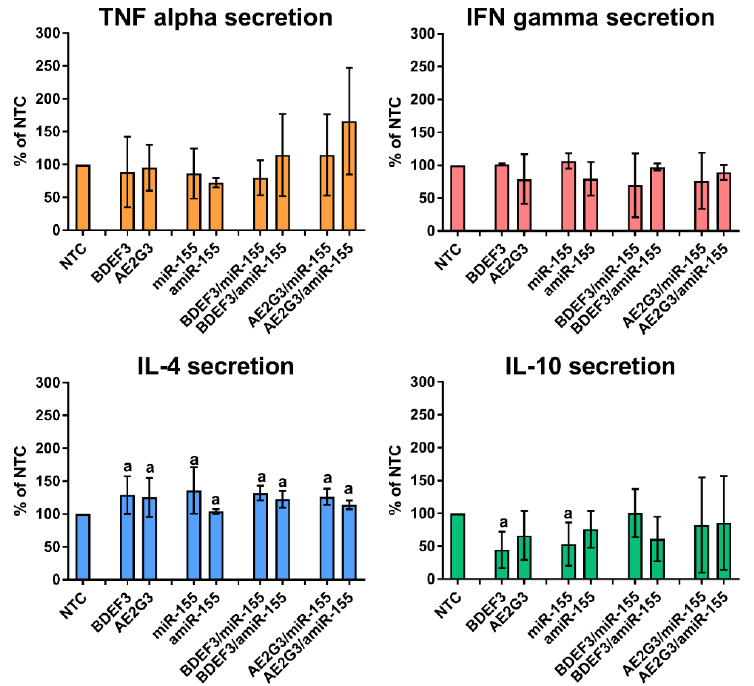
Figure 6. Evaluation of secretion of cytokines after 72 h of treatment by dendriplexes and their free complexes, being expressed as percentage of values measured for non-treated control (NTC). Mann – Whitney test was used. Letter “a” marks significant differences ( p < 0.05) in comparison with NTC. Secretion of IL-4 increased after treatment by free dendrimers ( p = 0.007 for both BDEF33 and AE2G3), and free miRs ( p = 0.03). Adding of dendriplexes also led to higher